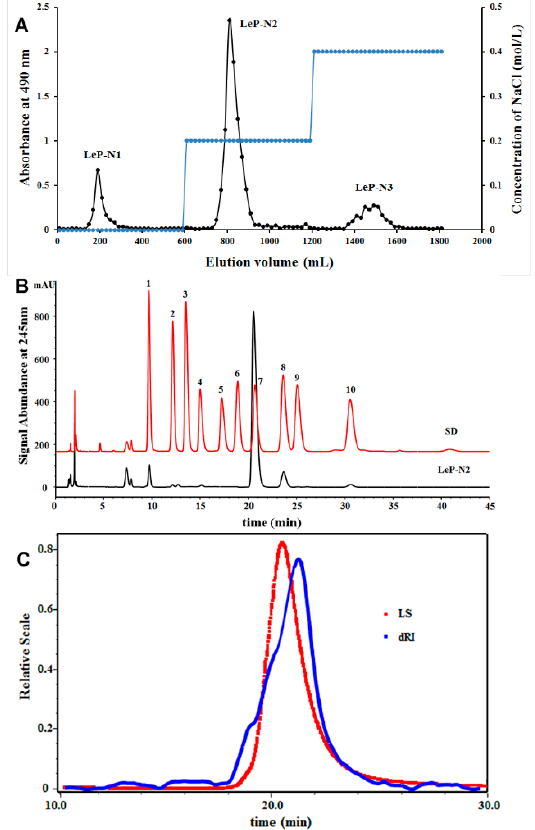
Figure 1. The purification and chemical properties of LeP-N2: ( A ) A stepwise elution curve of crude polysaccharide (LeP-N) from Lentinus edodes on a Q-Sepharose Fast Flow (QFF) strong anion-exchange column. ( B ) A high-performance liquid chromatography (HPLC) chromatogram of the monosaccharide composition (1. Man, 2. GlcN, 3. Rha, 4. GlcA, 5. GalA, 6. GalN, 7. Glc, 8. Gal, 9. Ara, and 10. Fuc). ( C ) The molecular weight distribution by HPGPC-RI-MALLS in a 0.1 M Na 2 SO 4 aqueous